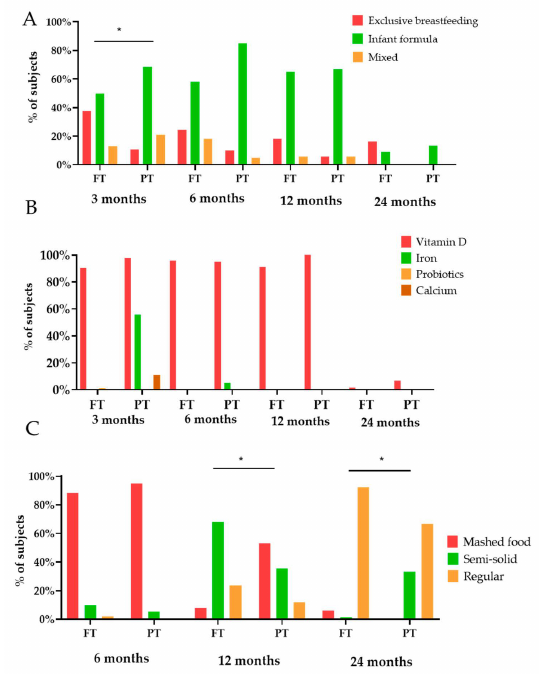
Figure 3. Differences between full-term (FT) and preterm (PT) infants regarding dietary characteristics (( A ) type of lactation, ( B ) type of suplementatition and ( C ) food texture), according to age. Fisher’s test was used for intra-group comparisons. * p <